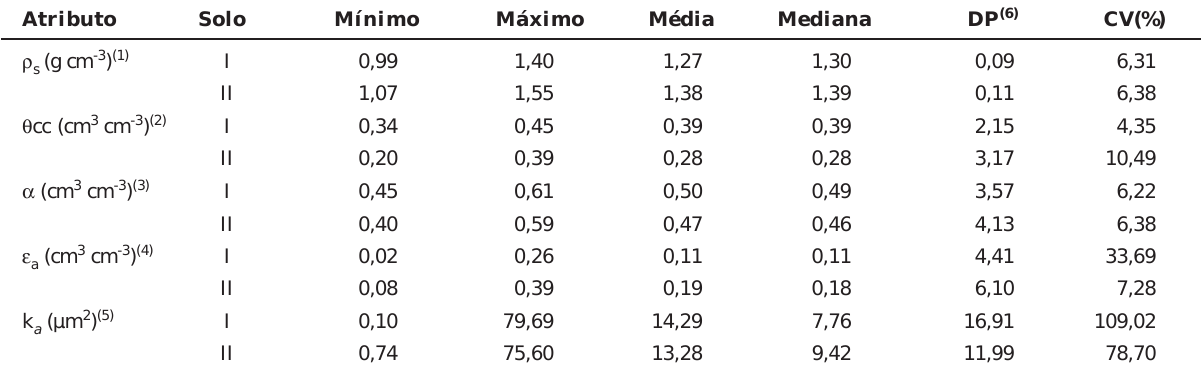
Quadro 3. Momentos estatísticos para os atributos físicos de dois Latossolos Vermelhos distróficos sob plantio direto, um argiloso (solo I) e um franco-argilo-arenoso (solo II)